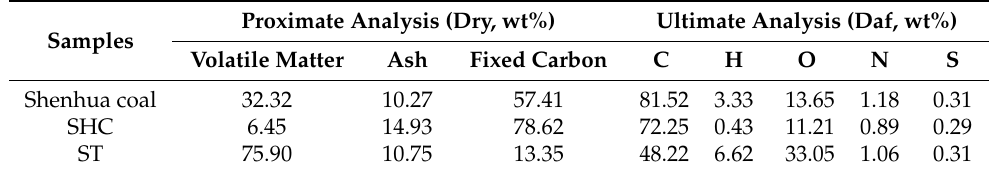
Table 1. Proximate analysis and ultimate analysis of